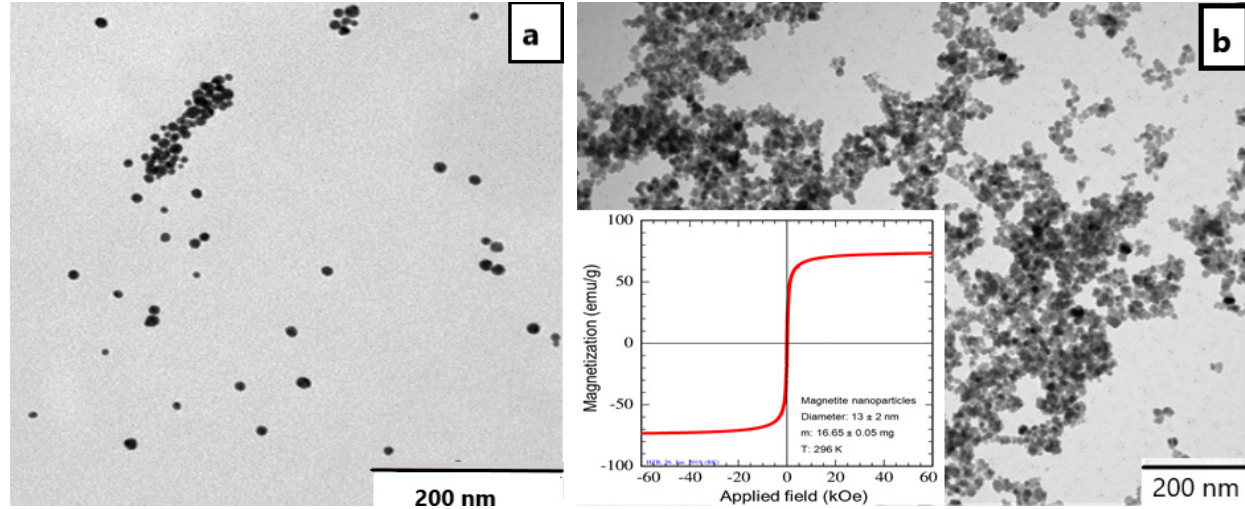
Figure 1. TEM micrographs of chitosan-stabilized AuNPs ( a ) and separately prepared MNPs with the corresponding magnetization curve ( b ).